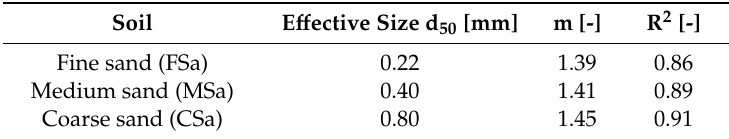
Table 2. Empirical constants in the relationship between porosity and electrical resistivity according to Equation (5) [45].